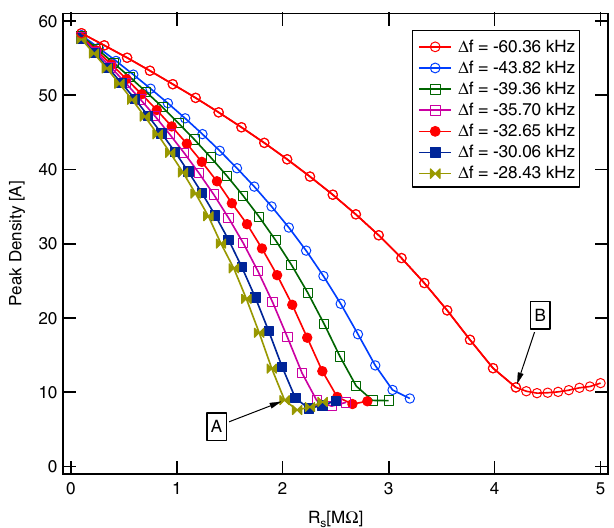
FIG. 5. Peak current as a function of harmonic cavity shunt impedance for various values of harmonic cavity detuning. The points identified by A and B correspond to the cases displayed in the plots of Fig. 1 and Fig. 2,